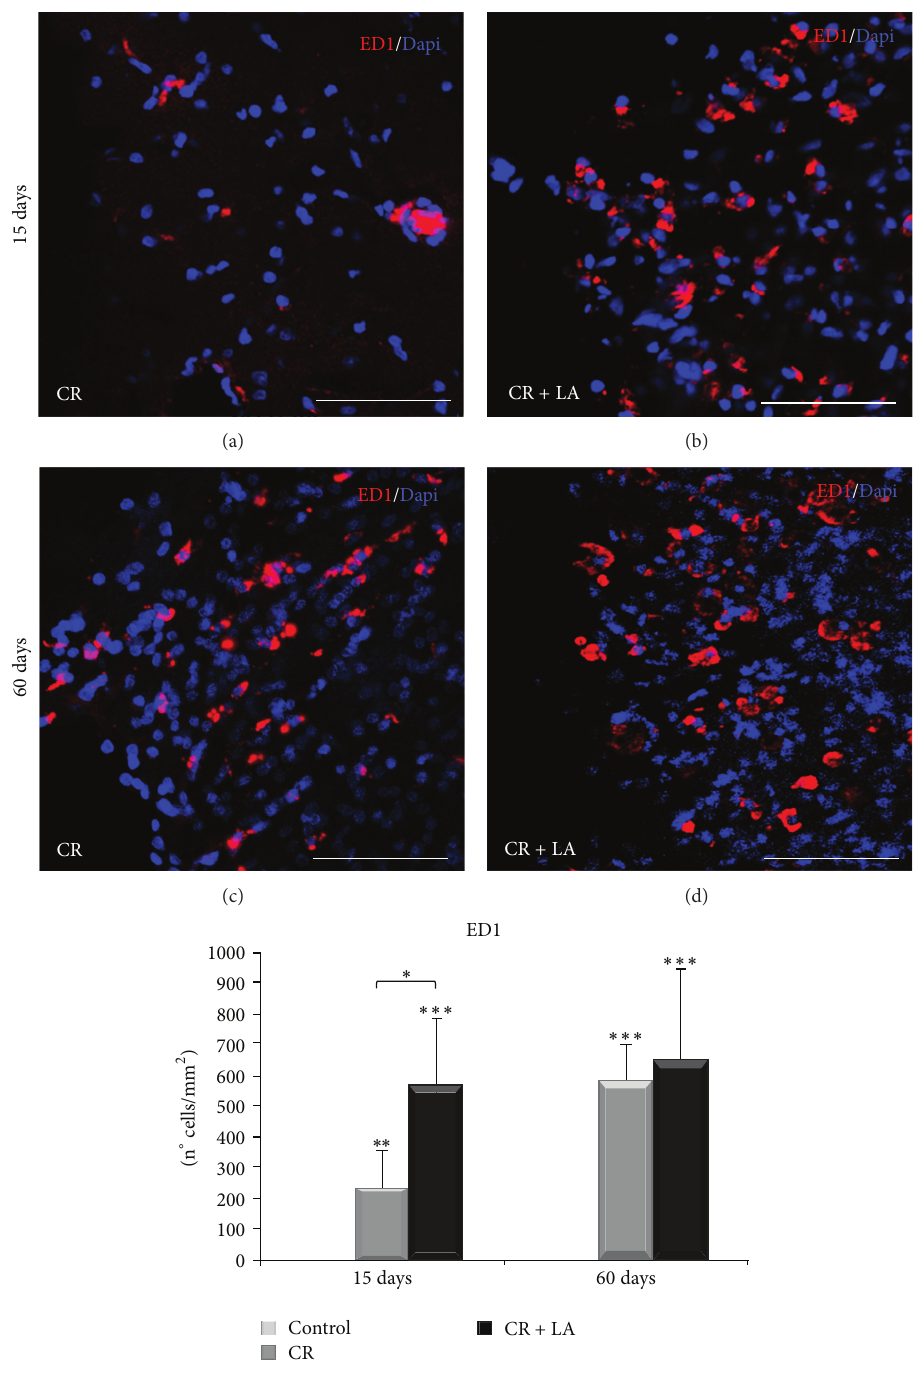
Figure 5: Immunofluorescence for ED1 marker (red) at 15 and 60 days in nontreated animals ((a) and (c), resp.) and LA treated animals ((b) and (d), resp.). Nuclei become evident with Dapi (blue). Quantification of cell density (n ∘ cells/mm 2 ) of activated microglia/macrophage (e) Scale bar: 200 𝜇 m. ∗∗ 𝑃 < 0.05 ; ∗∗ 𝑃 < 0.01